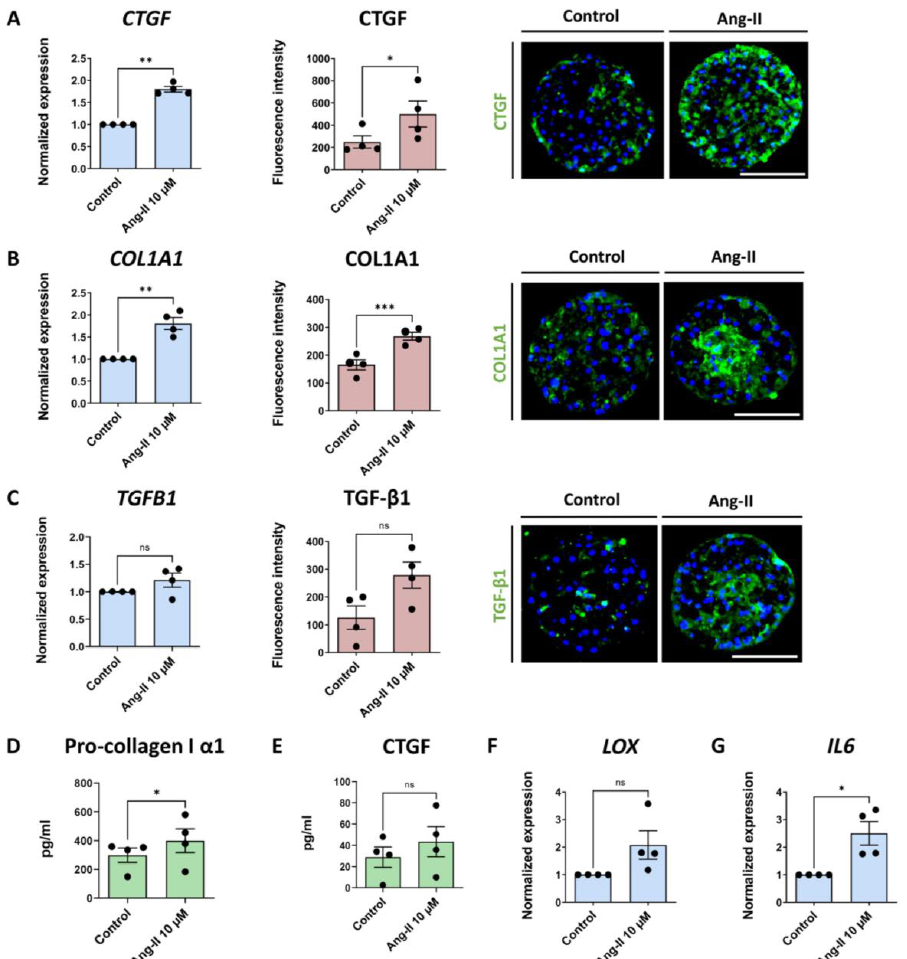
Figure 5. Angiotensin II induces CTGF production and markers of liver fibrosis . Angiotensin II was used to increase CTGF production and induce fibrosis in liver spheroids. Blue bars present the mRNA level data, red bars, results of IHC analysis, and green bars, data acquired using ELISA. ( A ) Angiotensin II caused an increase in CTGF expression (n = 4; 3 experiments with the PHH donor 1 and 1 experiment with PHH donor 2; NPC from donor 3 in all 4 experiments) and production (n = 4; 3 experiments with the PHH donor 1 and 1 experiment with PHH donor 2; NPC from donor 3 in all 4 experiments). ( B ) Expression and protein production of COL1A1 increased after angiotensin II treatment (n = 4). ( C ) TGF- β1 was increased on the protein level (n = 4), however the transcriptional level was unaffected (n = 4). ( D ) Pro- collagen I α1 released from the cells increased during the last 2 days of culture of the angiotensin II-treated spheroids (n = 4). ( E ) Similarly, the CTGF concentration in the culture medium was increased in all 4 experiments, although not to a significant extent (n = 4). ( F , G ) LOX and IL6 mRNA expression increased due to angiotensin II treatment (n = 4; 3 experi- ments with PHH donor 1 and 1 experiment with PHH donor 2; NPC from donor 3 in all 4 experi- ments). Nuclei in the IHC images are shown in blue. Every dot in the plots represents data from 1 experiment. Every dot in the red graphs is the average of at least 10 analyzed sections of spheroids per experiment. The size of the spheroids is marked with a white scale bar of 100 μm. Data are shown as mean ± SEM. Statistical analysis — Student ’ s t -test; * p < 0.05; ** p < 0.01; *** p < 0.001; ns: not significant. Ang-II — angiotensin II.